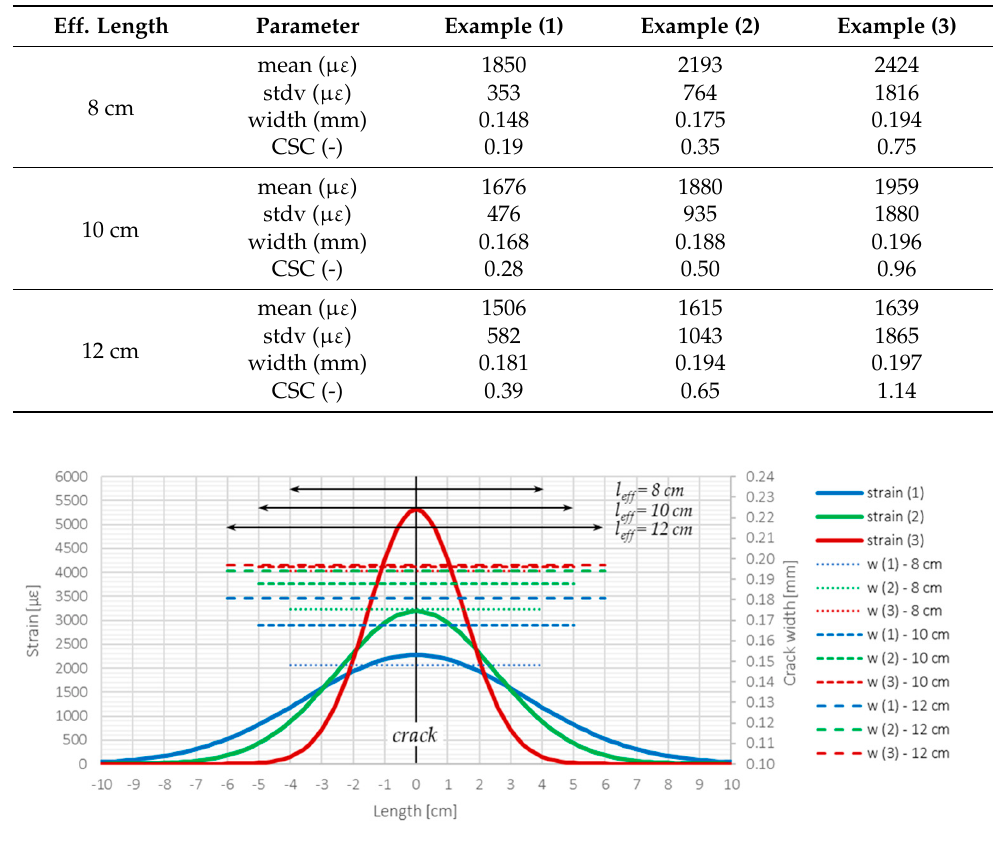
Figure 26. Graphical presentation of different strain profiles and corresponding parameters related to crack analysis (compared to Table 4).